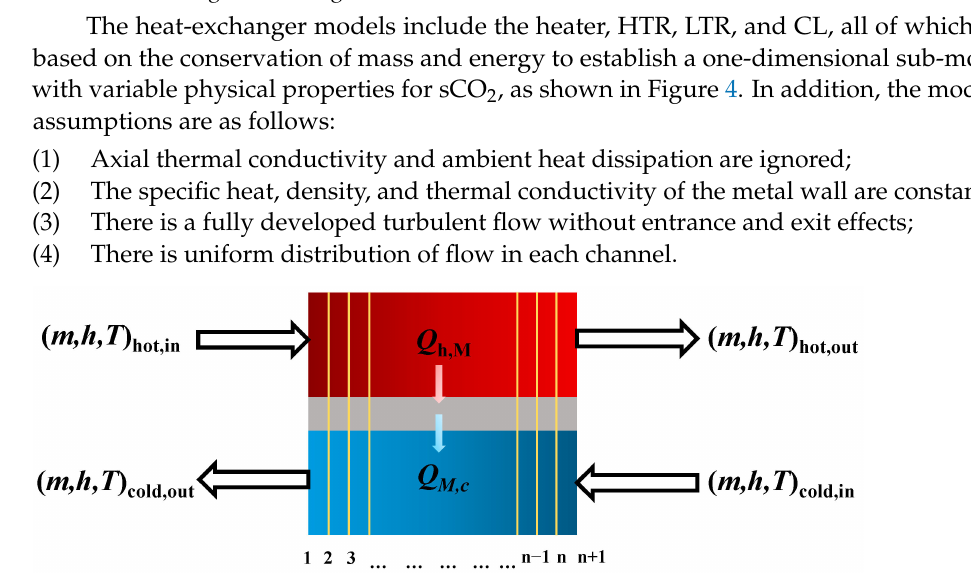
Figure 4. One-dimensional segmentation model with variable physical properties. The HTR and LTR are PCHEs in straight-channel forms, and the CL is of the microtube type. The heater’s internal combustion is not the focus of this study, so it is simplified by a lumped parameter model. The enthalpy-based method is used to calculate the conservation equation of the hot side, the cold side, and the wall in the enthalpy space. The Gnielinski correlation [30] and Petukhov correlation [31] are used for heat transfer and pressure drop on the CO 2 side, respectively, and the Chu [32] correlation is used for heat transfer on the water